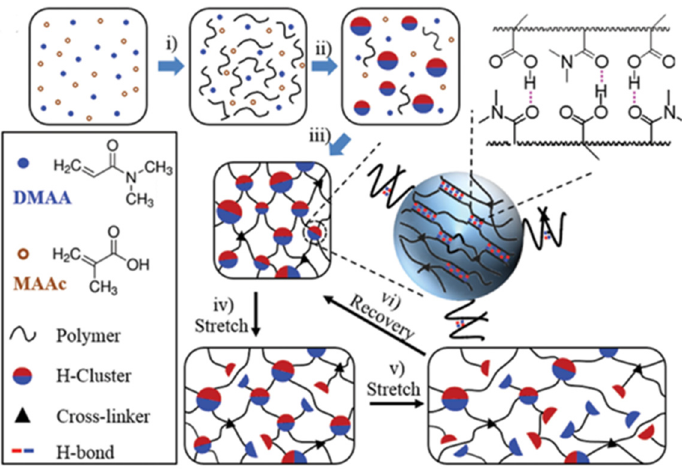
Figure 8. Preparation mechanism of DMAA-co-MAAc gels. (Reprinted/adapted with permission from Ref. [55], 2015, Hu et al.).